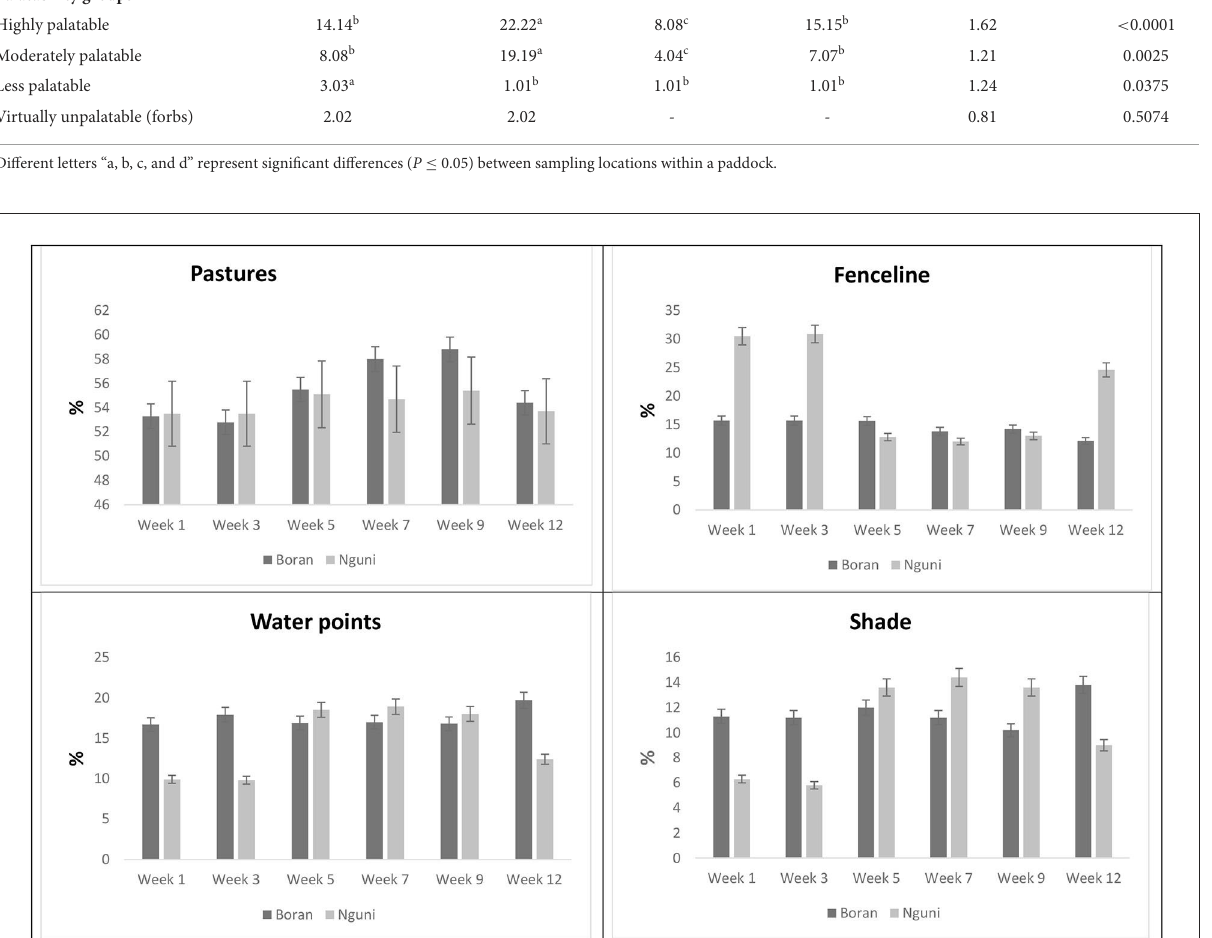
than in the successive weeks. Genotype and observation period showed a significant interaction ( P < 0.0001) in response to time spent along water points. The two breeds spent